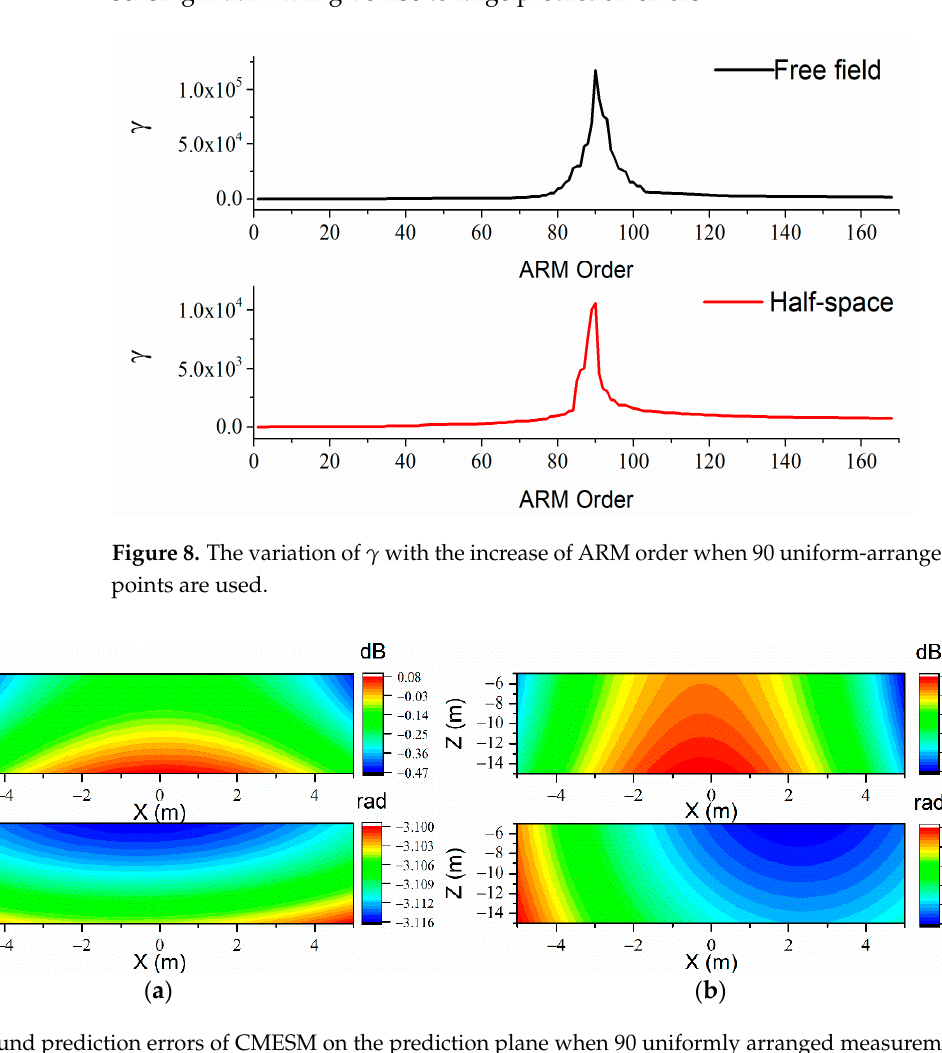
Table 4. Different ARM truncation numbers in CMESM for 135 measurement points.